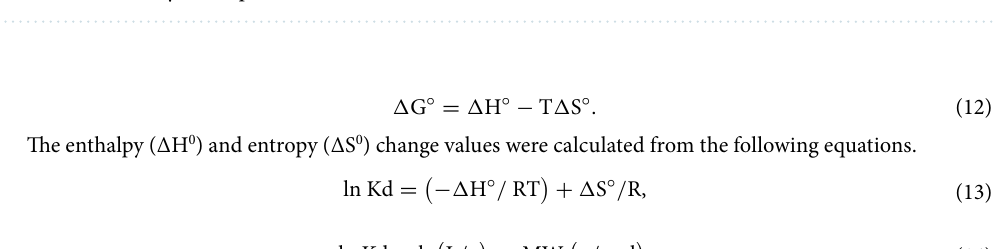
Table 5. Thermodynamic